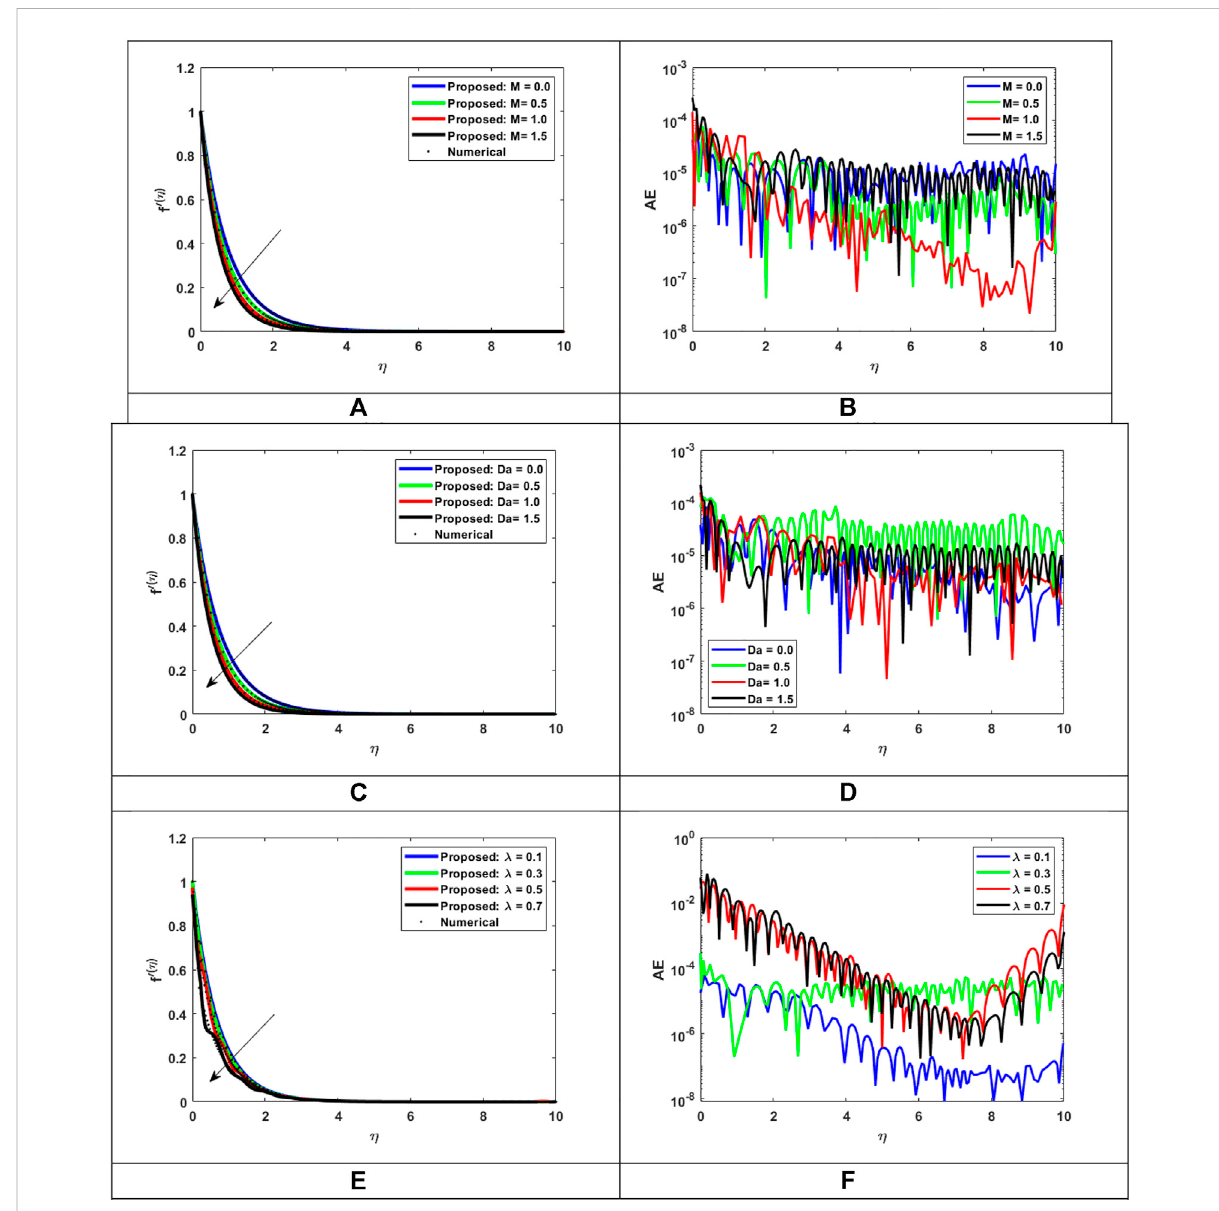
FIGURE 13 Assessment of LMLA-BPNN with reference dataset of MHD-WNF-HGA. (A) Variation of M for f ′ ( η ) , (B) AE for MHD-WNF-HGA, (C) Variation of Da for f ′ ( η ) , (D) AE for MHD-WNF-HGA, (E) Variation of λ for f ′ ( η ) , (F) AE for